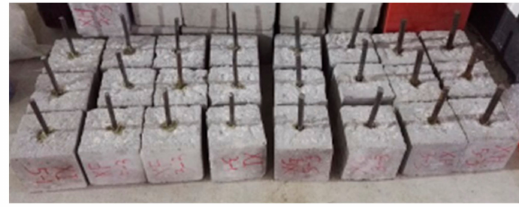
Figure 12. Reinforced old concrete